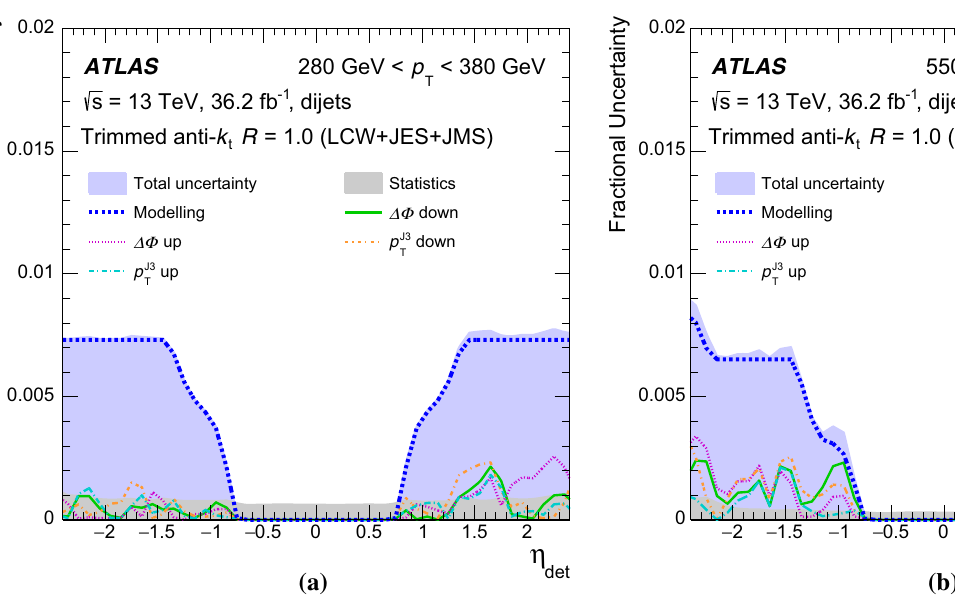
Fig. 5 The relative large- R jet response R rel as a function of the large- R jet p T in two representative detector pseudorapidity η det bins in the forward and central reference regions a 1 . 7 < η det < 1 . 8 and